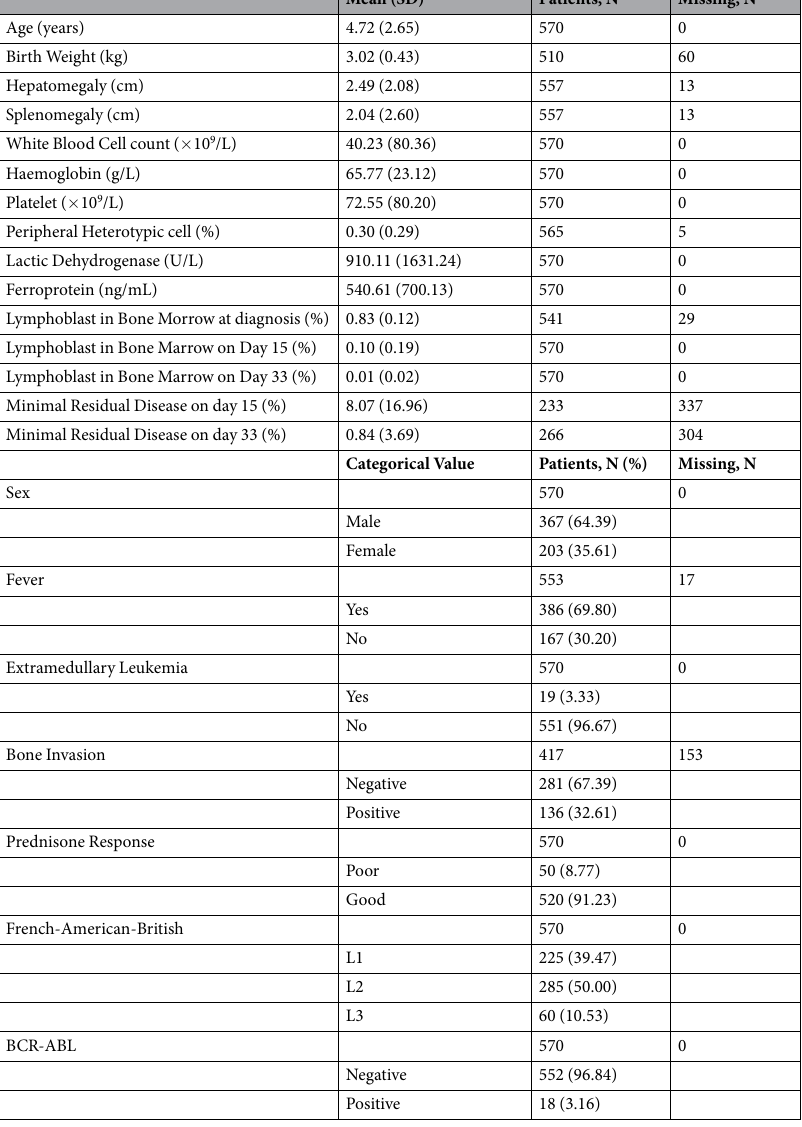
Table 1. Part of Patient